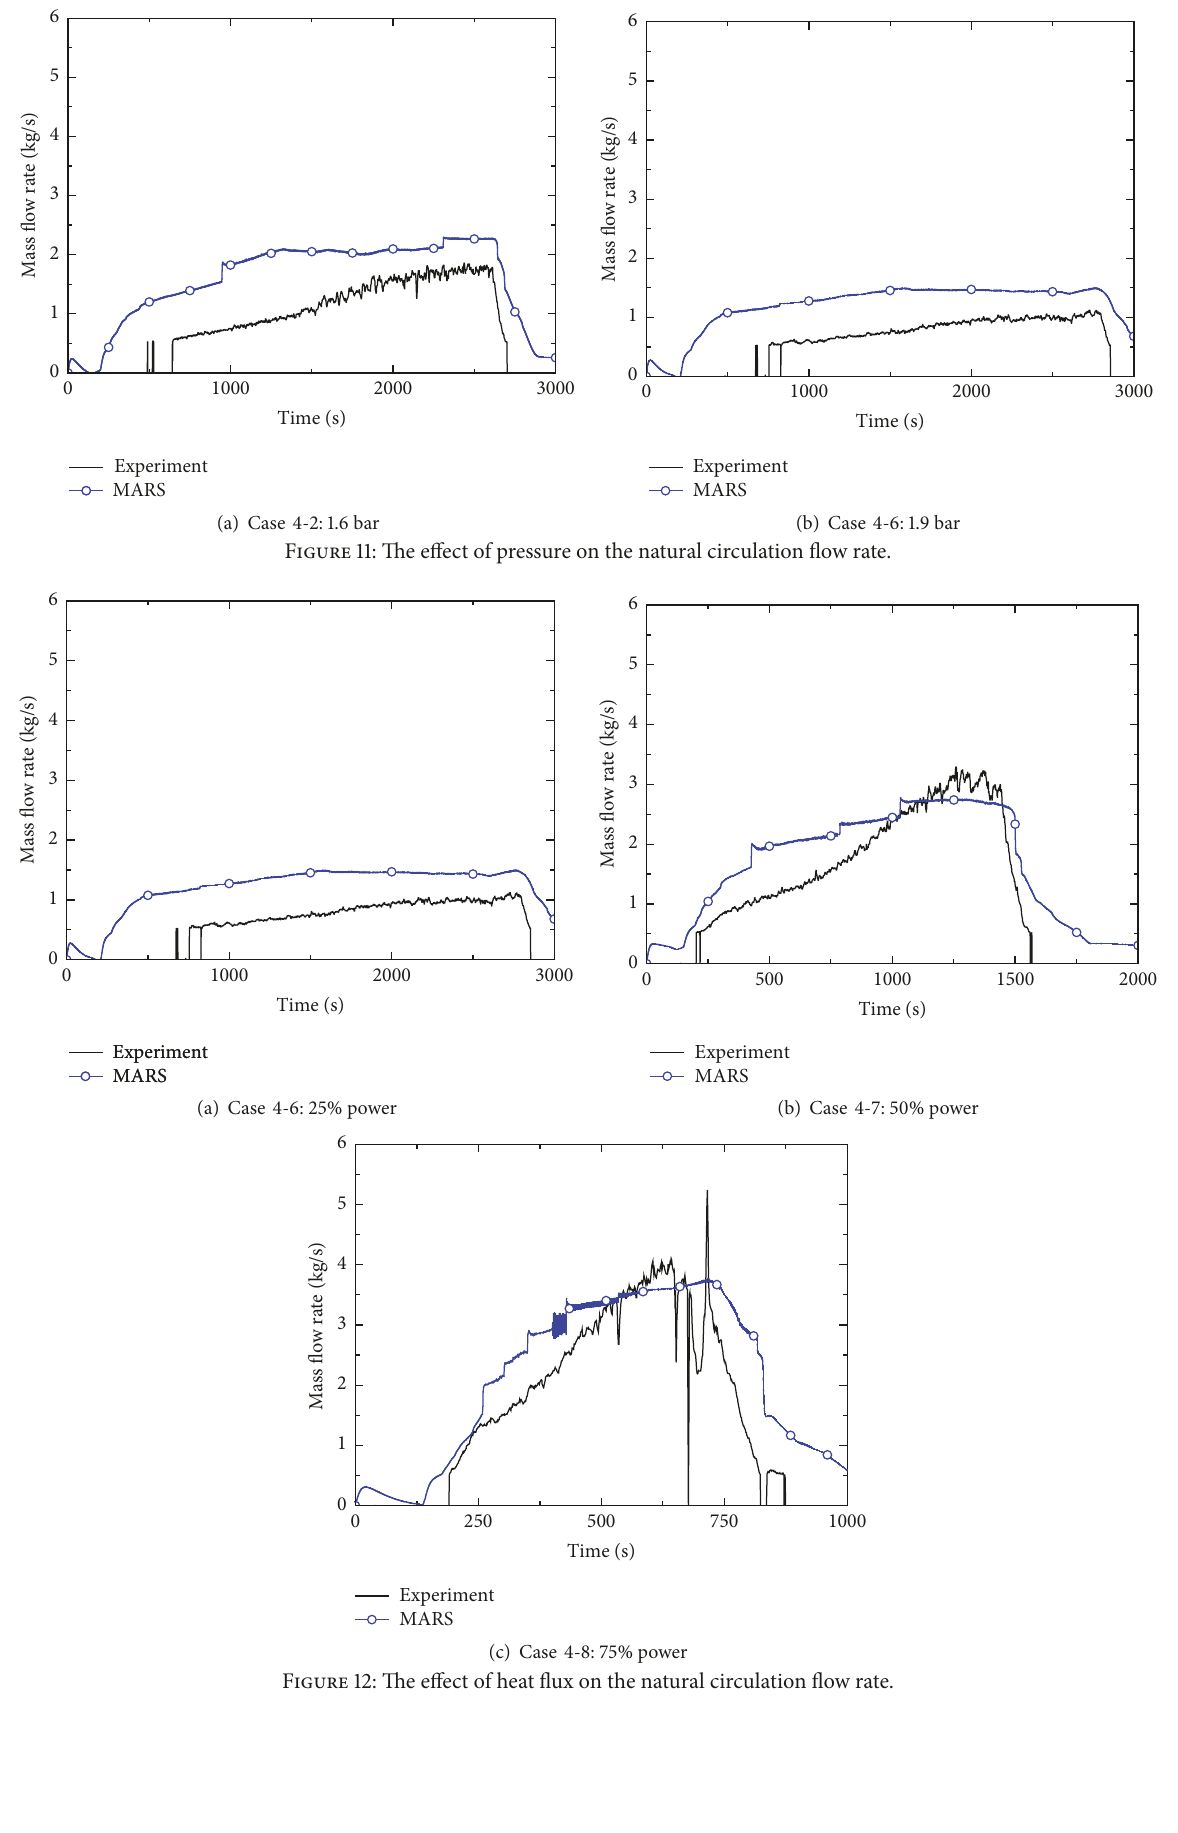
Figure 12: The effect of heat flux on the natural circulation flow